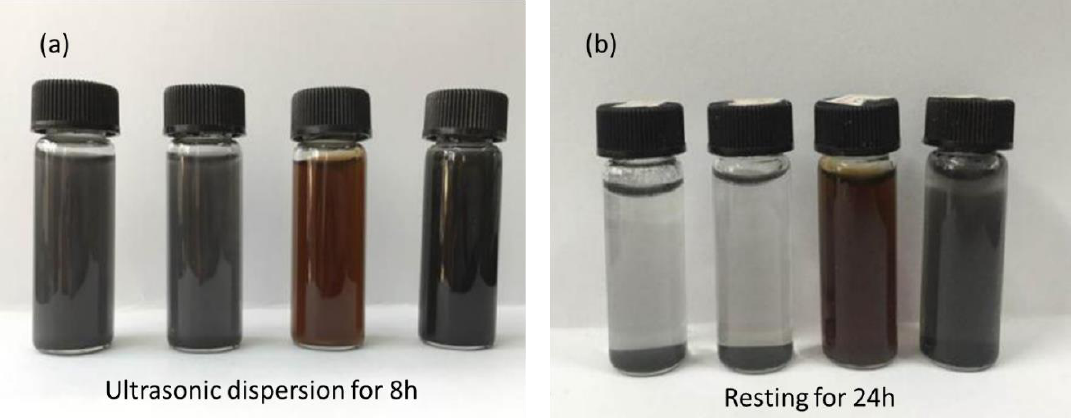
Figure 8. Dispersion of graphite, oxidized expanded graphite, graphene oxide, and active graphene dispersion, from left to right respectively, in: ( a ) Ultrasonic dispersion for 8 h; ( b ) resting for 24 h.